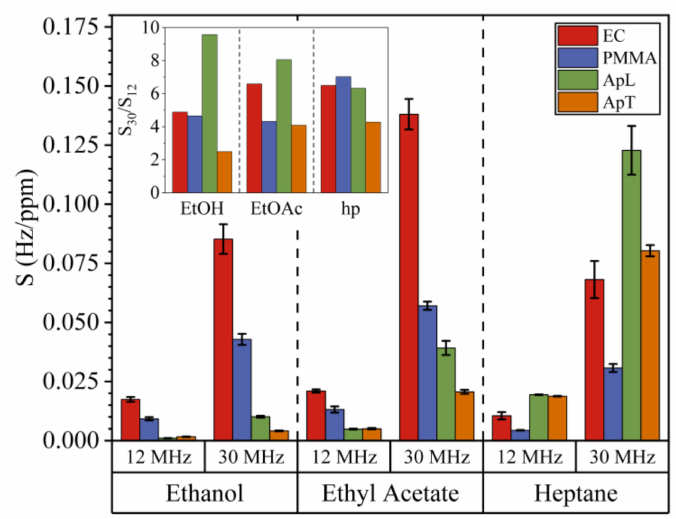
Figure 5. Comparison of sensitivities for 12QCM-SA and 30QCM-SA exposed to ethanol, ethyl acetate, and heptane. In the inset, the ratio between both sensitivities ( S 30 / S 12 ) is shown. The maximum deviation was 11% (error